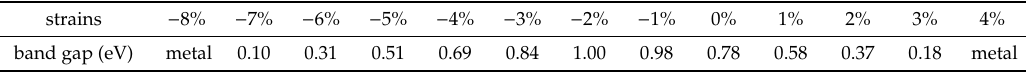
Figure 4. The electronic band structures of the Sb/MoS 2 hetero-bilayer under different in-plane biaxial strain: ( a ) ε = − 3%, ( b ) ε = − 2%, ( c ) ε = − 1%, ( d ) ε = 0%, ( e ) ε = 1%, ( f ) ε = 2%, ( g ) ε = 3%. Contribution from antimonene and MoS 2 monolayer to the band structures of the bilayers are shown with red and blue circle dots, respectively. The Fermi level is set to 0 eV. Table 3. Band gaps of compressed/stretched Sb/MoS 2 hetero-bilayer.